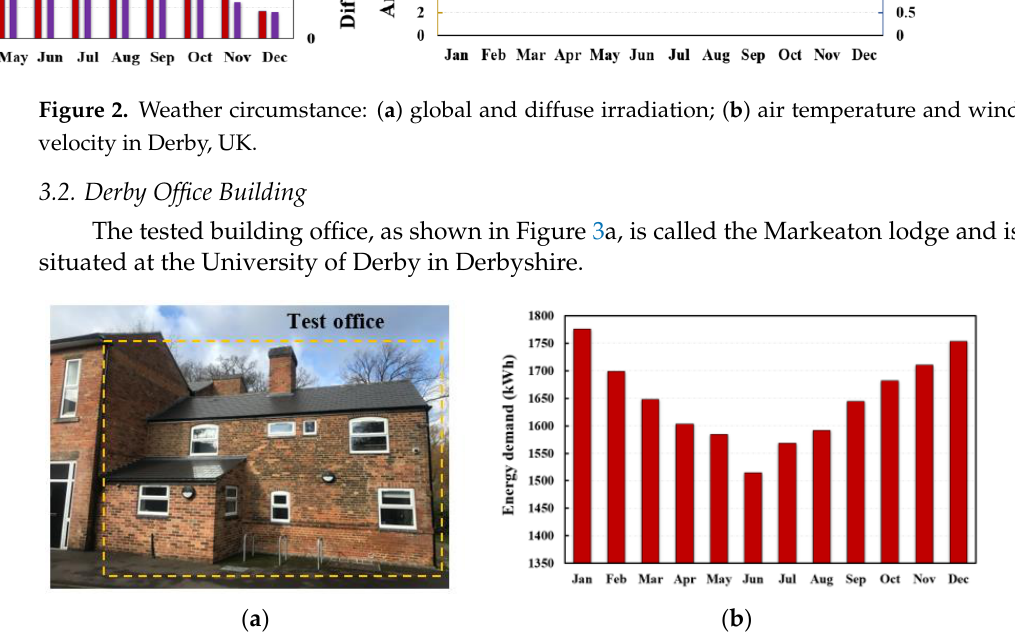
Figure 3. Weather circumstance: ( a ) global irradiation; ( b ) ambient air temperature and wind velocity in Derby, UK.